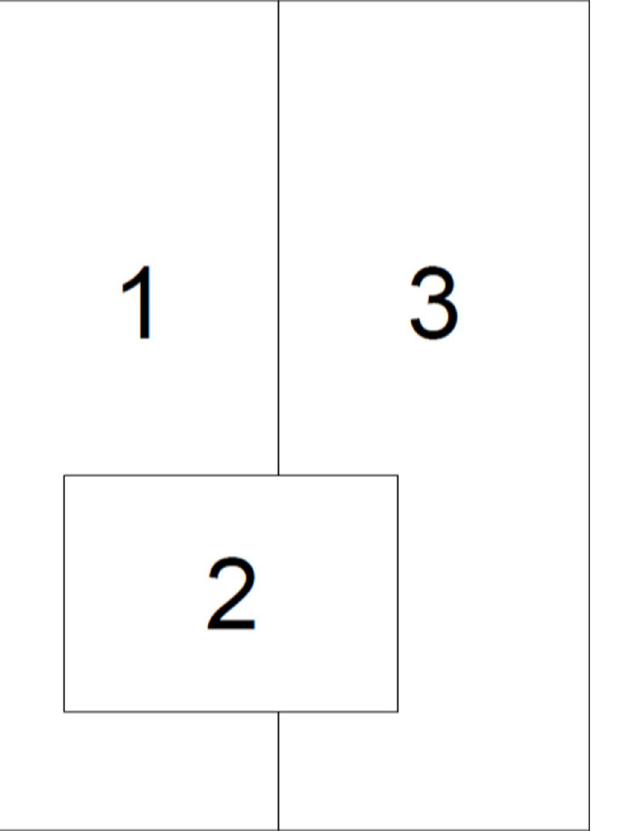
Fig 2. Small-scale test case hydrologic